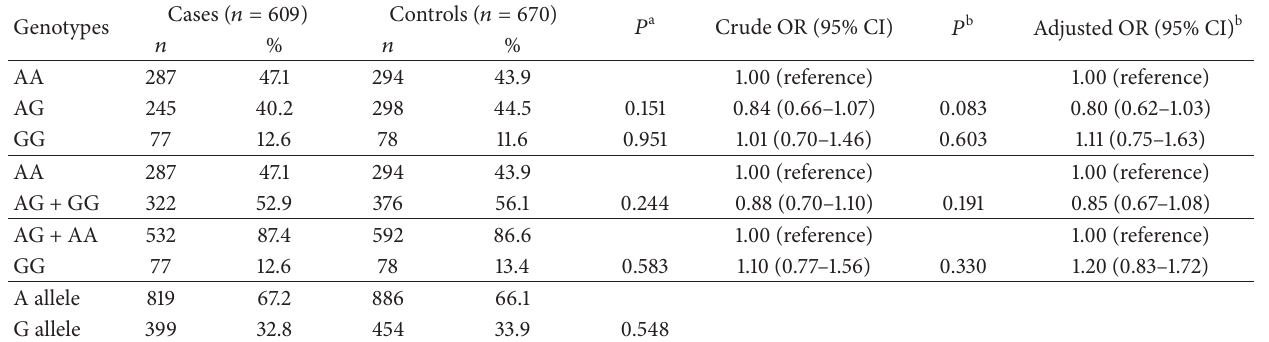
Table 2: Genotype and allele frequencies of the TSP-1 -1223 A/G polymorphism among the bladder cancer cases and controls. Genotypes